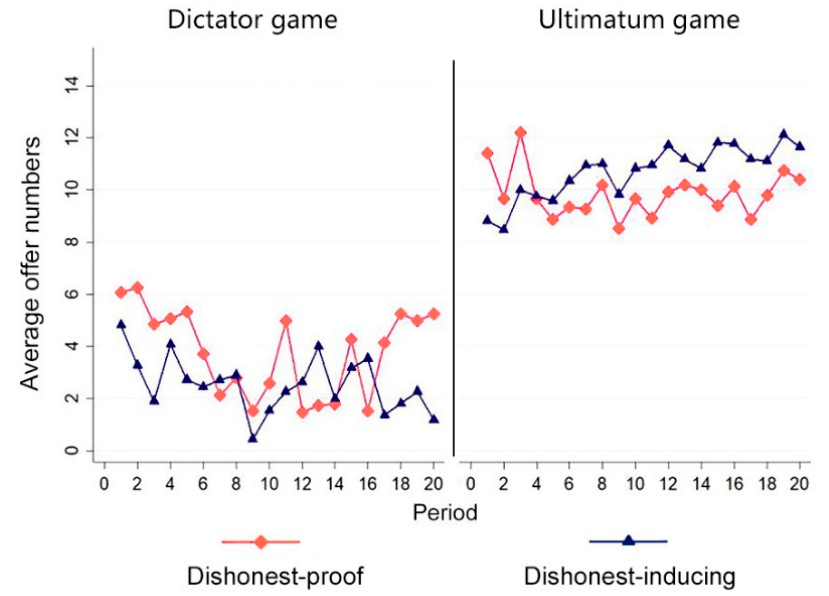
Figure 4. Changing trends of offers over time. Table 3. Tobit regression on money given to receivers.